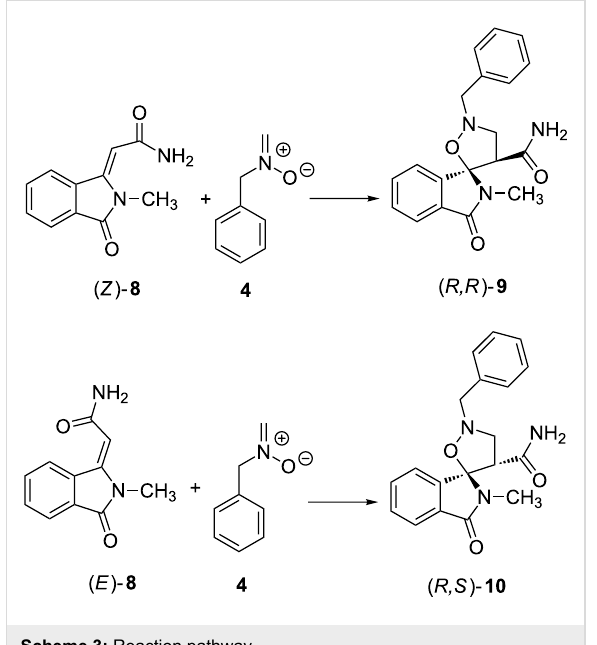
given in Table 2. The cycloadducts 9 and 10 are formed with a ratio of 92:8.